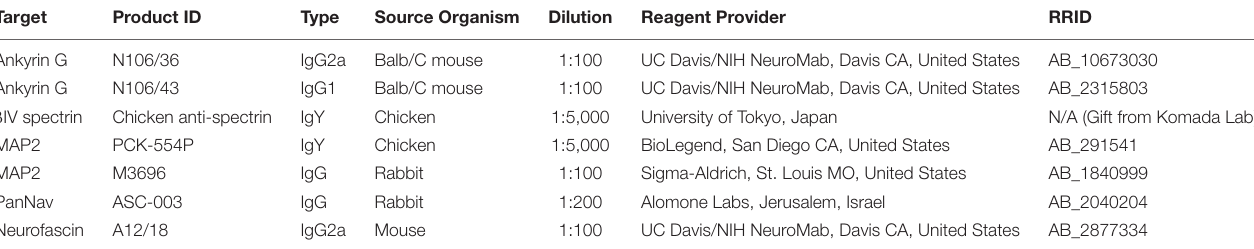
TABLE 1 | Antibodies used in this